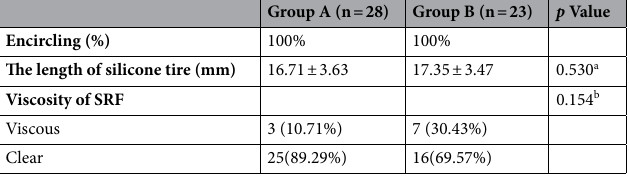
Table 2. The information of buckle configuration during surgery. a t -test. b Fisher exact